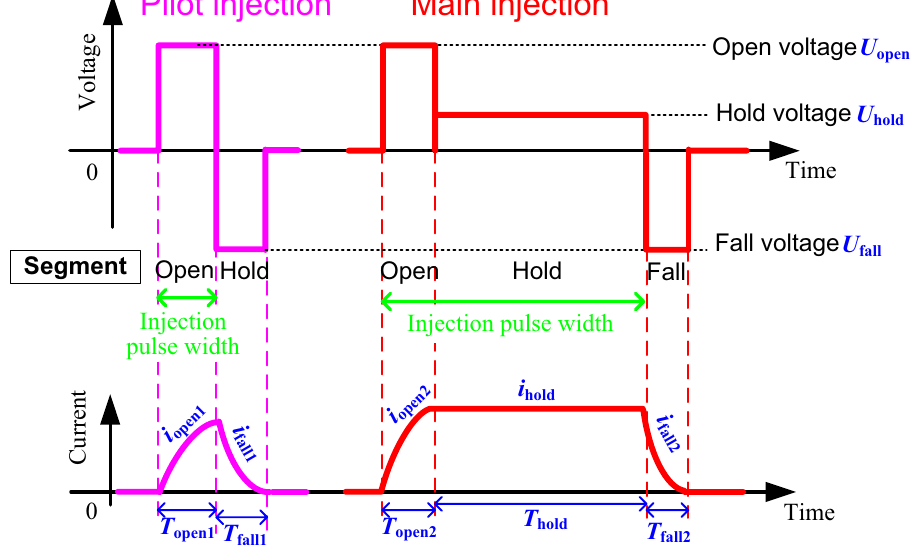
Figure 2. Voltage waves for a pilot injection and a main injection,